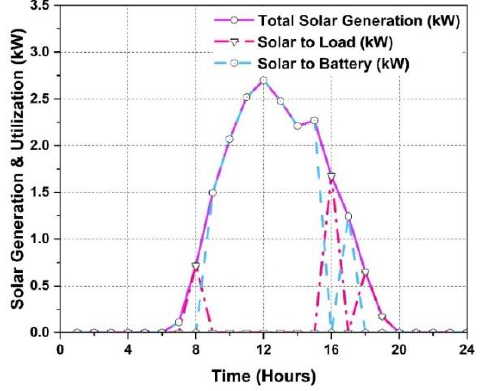
Figure 6. Solar total generation and utilization (off−grid) .